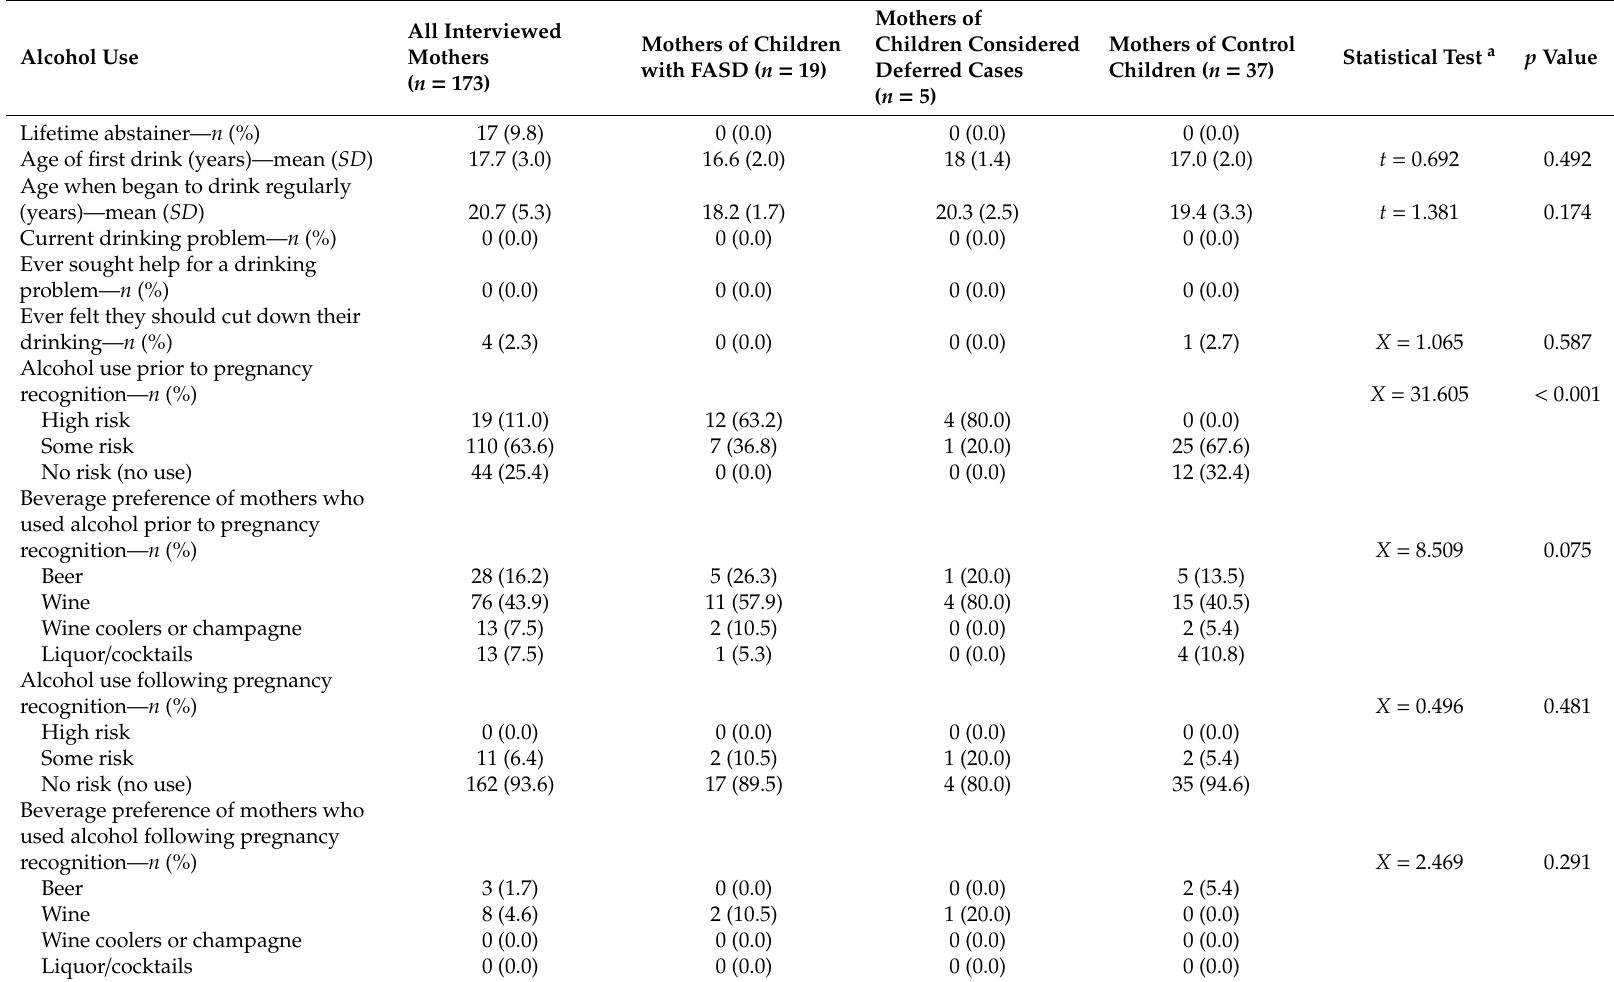
Table 4. Alcohol use during pregnancy among all interviewed mothers, mothers of children with FASD and mothers of control